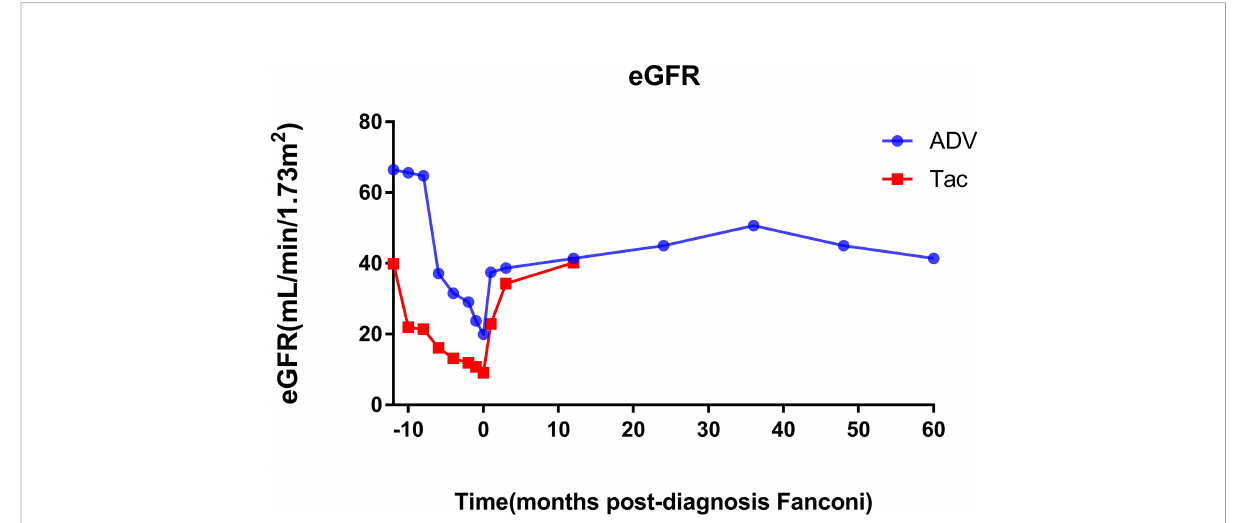
FIGURE 2 Changes of eGFR before and after diagnosis of Fanconi syndrome. eGFR, estimated glomerular fi ltration rate; ADV, adefovir dipivoxil; Tac, tacrolimus.